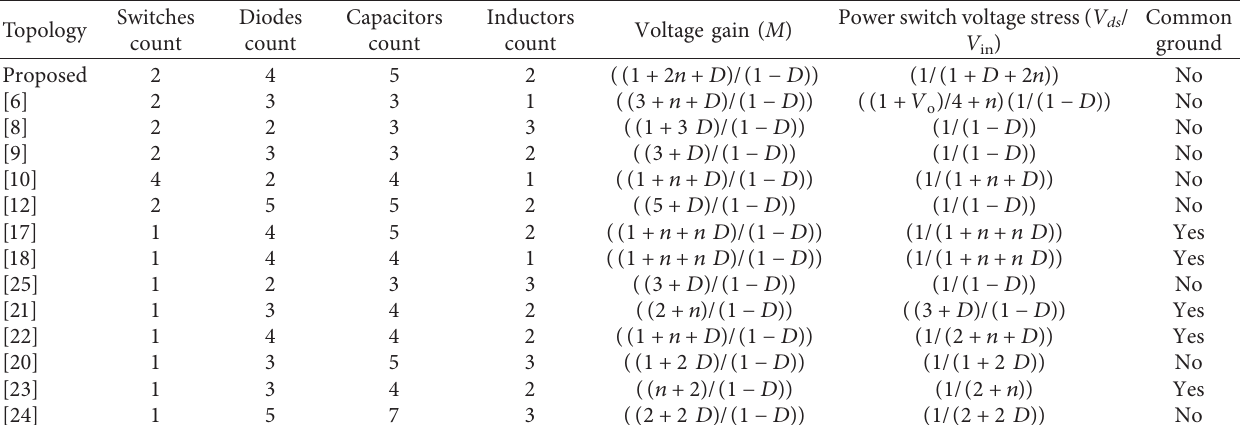
Figure 8: Voltage stress of capacitors, turns ratio n , and duty cycle Table 1: Performance comparison of different converters.